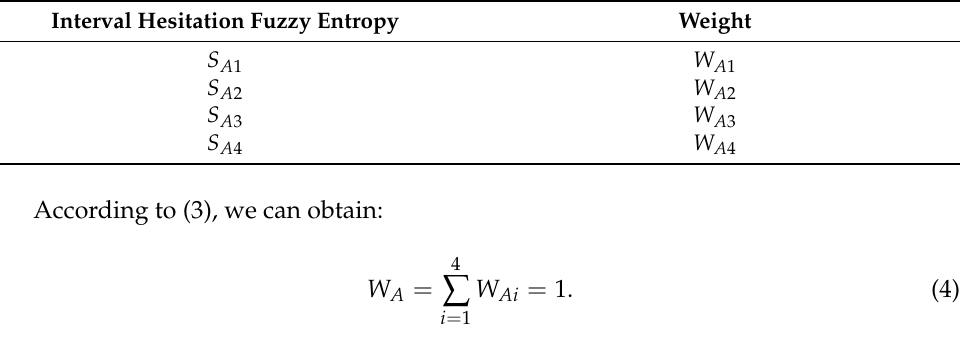
Table 3. Interval Hesitation Fuzzy Entropy and Weight of the First